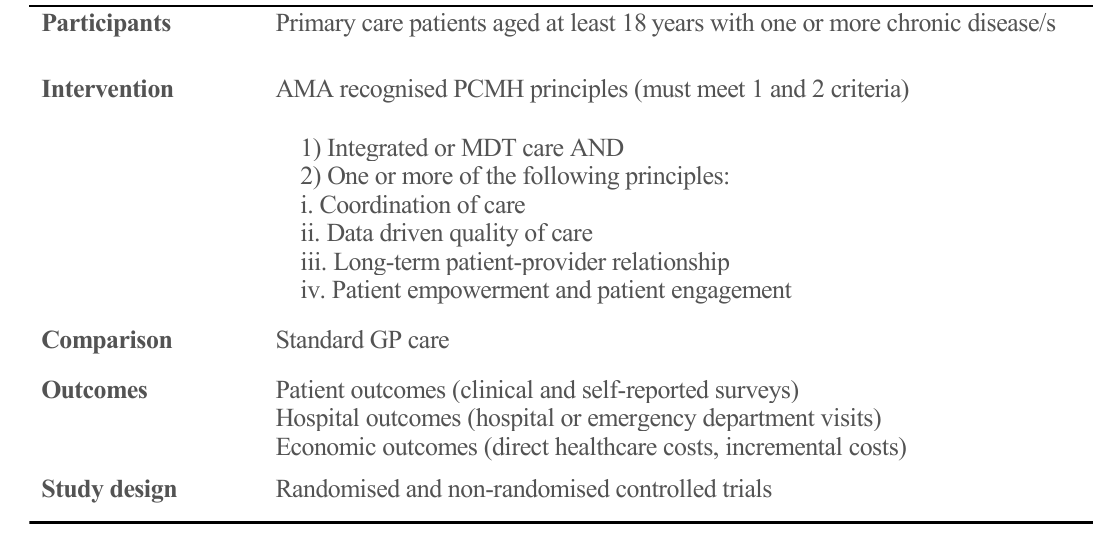
Figure 1. Summary of Population, Interventions, Comparators, Outcomes, and Study designs (PICOS) components. Outcomes included but not limited to patient, hospital, and economic outcomes.